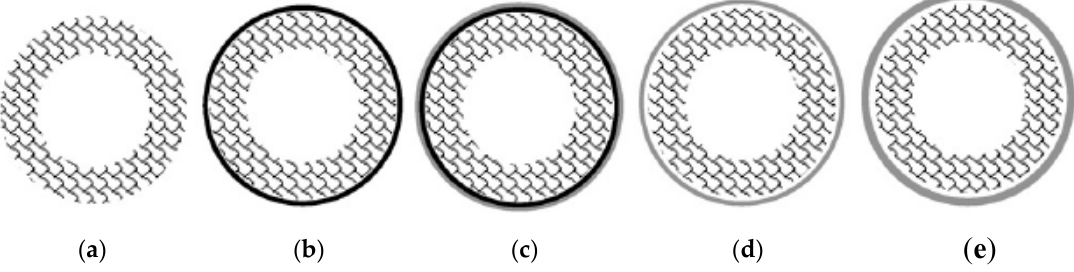
Figure 4. Use of a temporary intermediate layer for the preparation of a Pd-composite membrane: ( a ) original support; ( b ) polymer + support; ( c ) Pd layer + polymer + support; ( d ) Pd layer + small gap + support; and ( e ) defect-free Pd layer + small gap + support [150], with permission from © Elsevier.